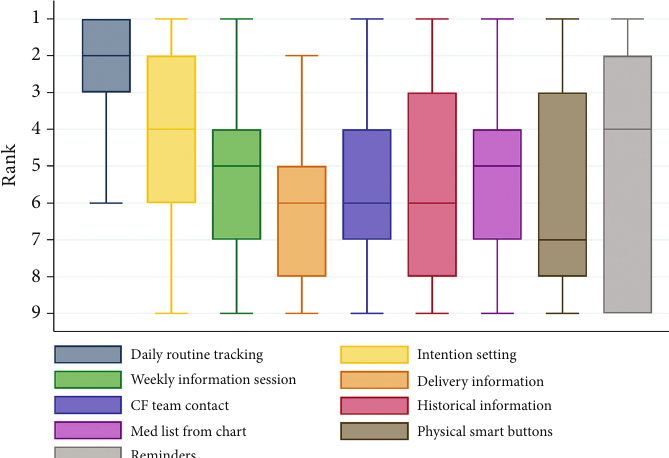
Figure 1: Patients ’ ranking of Phlo app features ( N = 23 ). Note: a ranking of 1 is the most important app feature. A ranking of 9 is the least important app feature. Results are presented as medians and interquartile ranges.